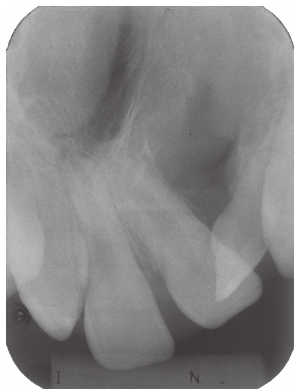
Figure 3- Pre-bone graft radiography